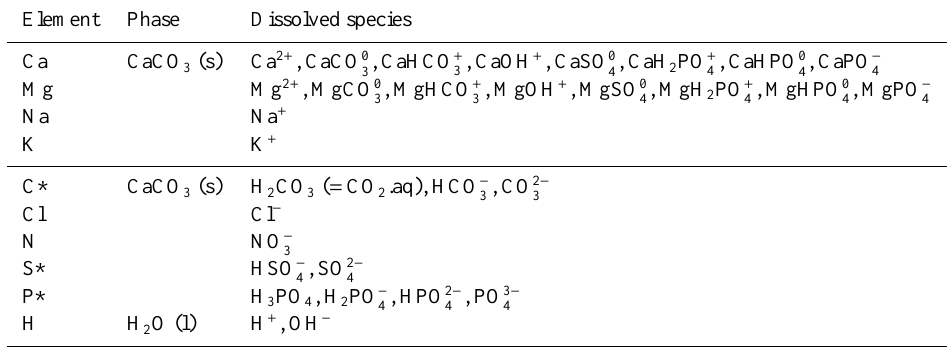
Table 2. Chemical elements, phases and dissolved species in DIN 38404-10 (2012).